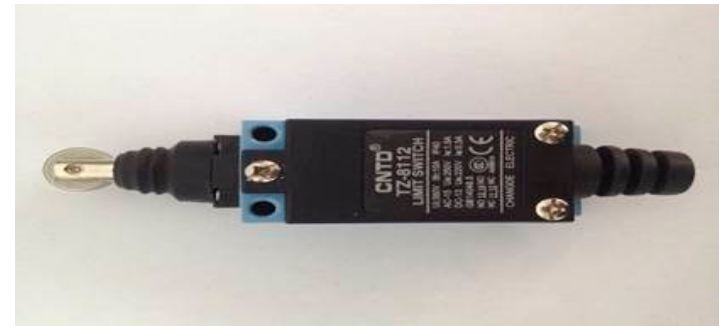
Figure 4. On-track inspection travel switch.